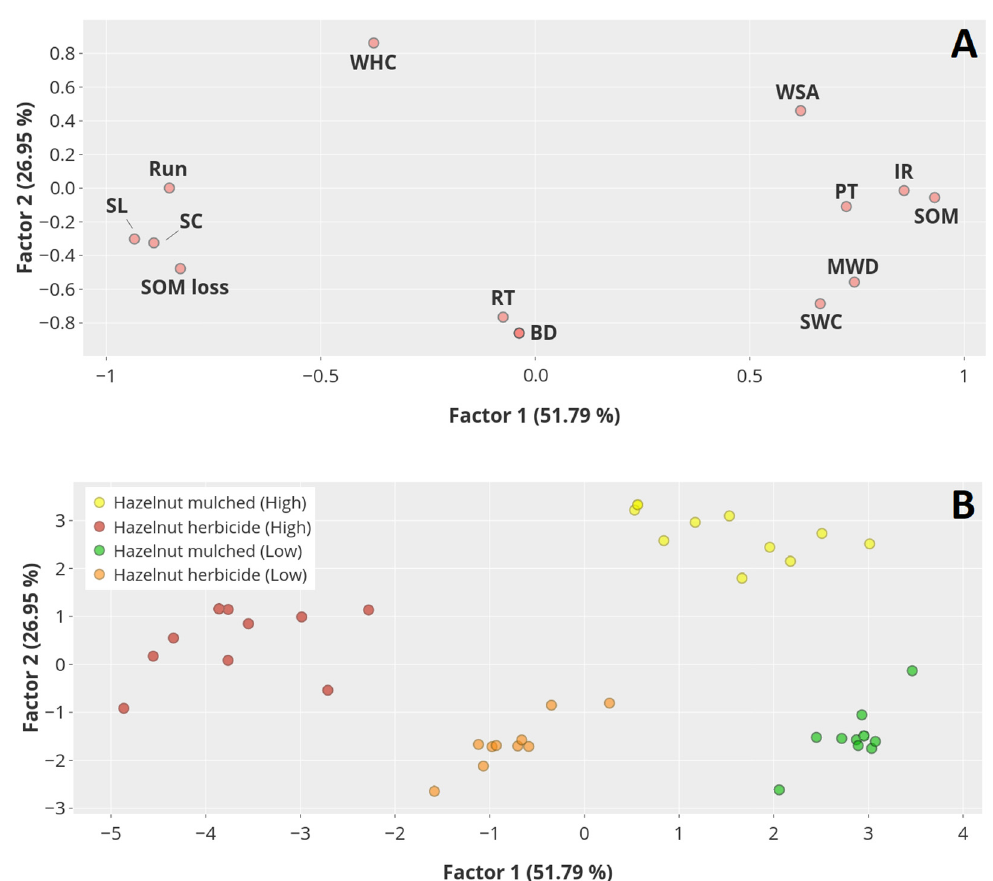
Figure 7. Relation between Factors 1 and 2: ( A ) Variables and ( B ) Cases; Bulk density (BD); water holding capacity (WHC); soil water content (SWC); mean weight diameter (MWD); water-stable aggregates (WSA); soil organic matter (SOM); time to ponding (PT); time to runoff (RT); infiltration rate (IR), runoff (Run), sediment concentration (SC); sediment loss (SL); soil organic matter loss (SOM loss).